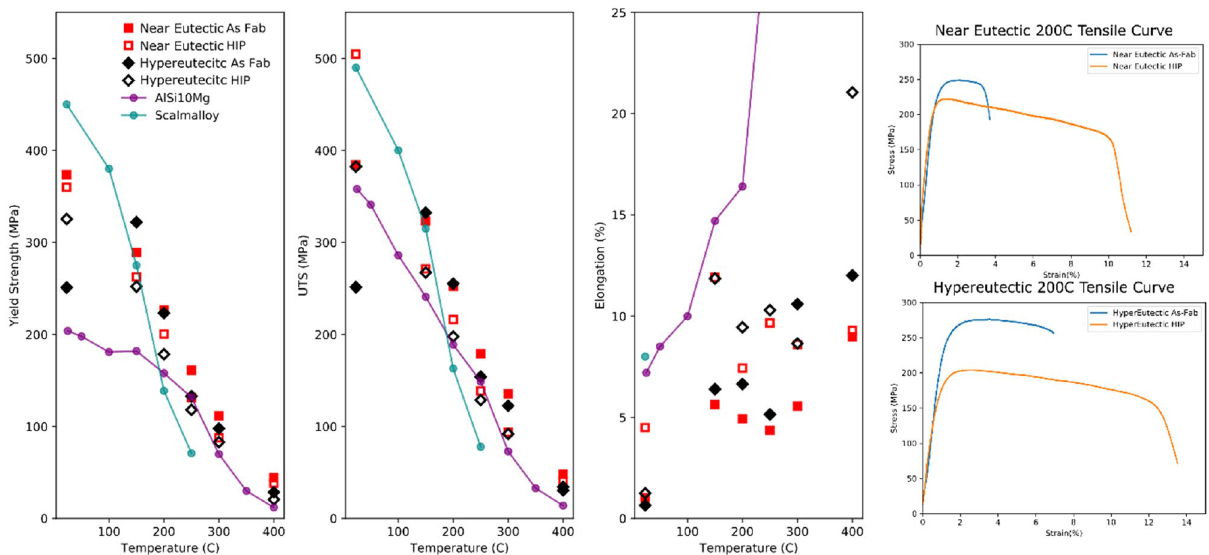
Figure 7. Averaged mechanical test data compared to some wrought alloys and published data for Scalmalloy 54 , and Al-10Si-Mg 16